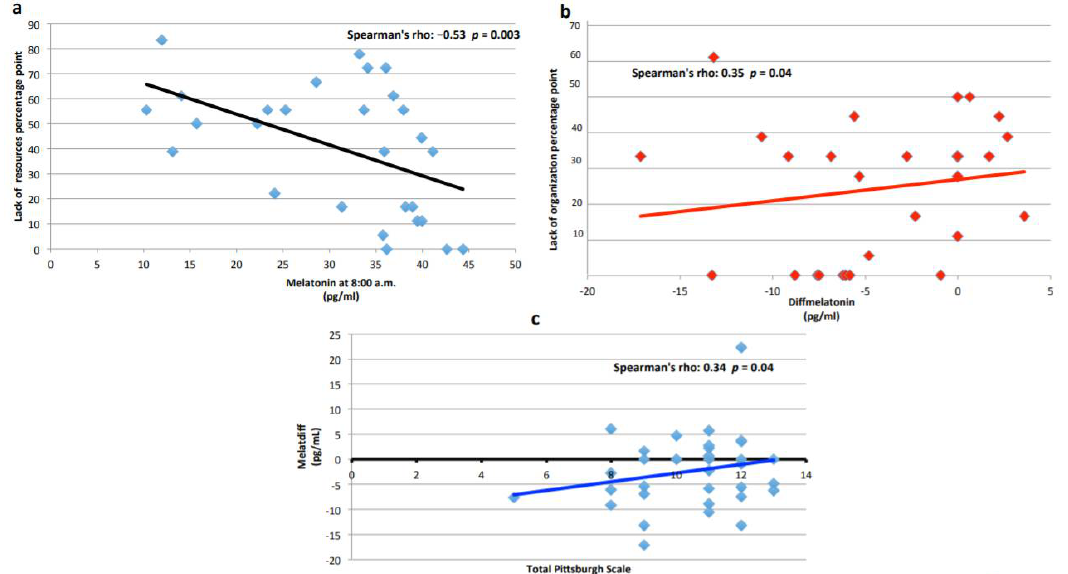
Figure 3. ( a ) Correlation of melatonin with subclasses of PSS and total PSQI score. The negative correlation of melatonin levels at 8:00 a.m. (pg/mL) and the PSS subclass “lack of resources” is shown with a Spearman’s rho = − 0.53 and p = 0.003. ( b ) Positive correlation of Melatdiff (pg/mL) and the PSS subclass lack of organization is shown with a Spearman’s rho = 0.35 and p = 0.04. ( c ) The positive correlation of Melatdiff (pg/mL) and total PSQI score is shown with a Spearman’s rho = 0.34 and p = 0.04.